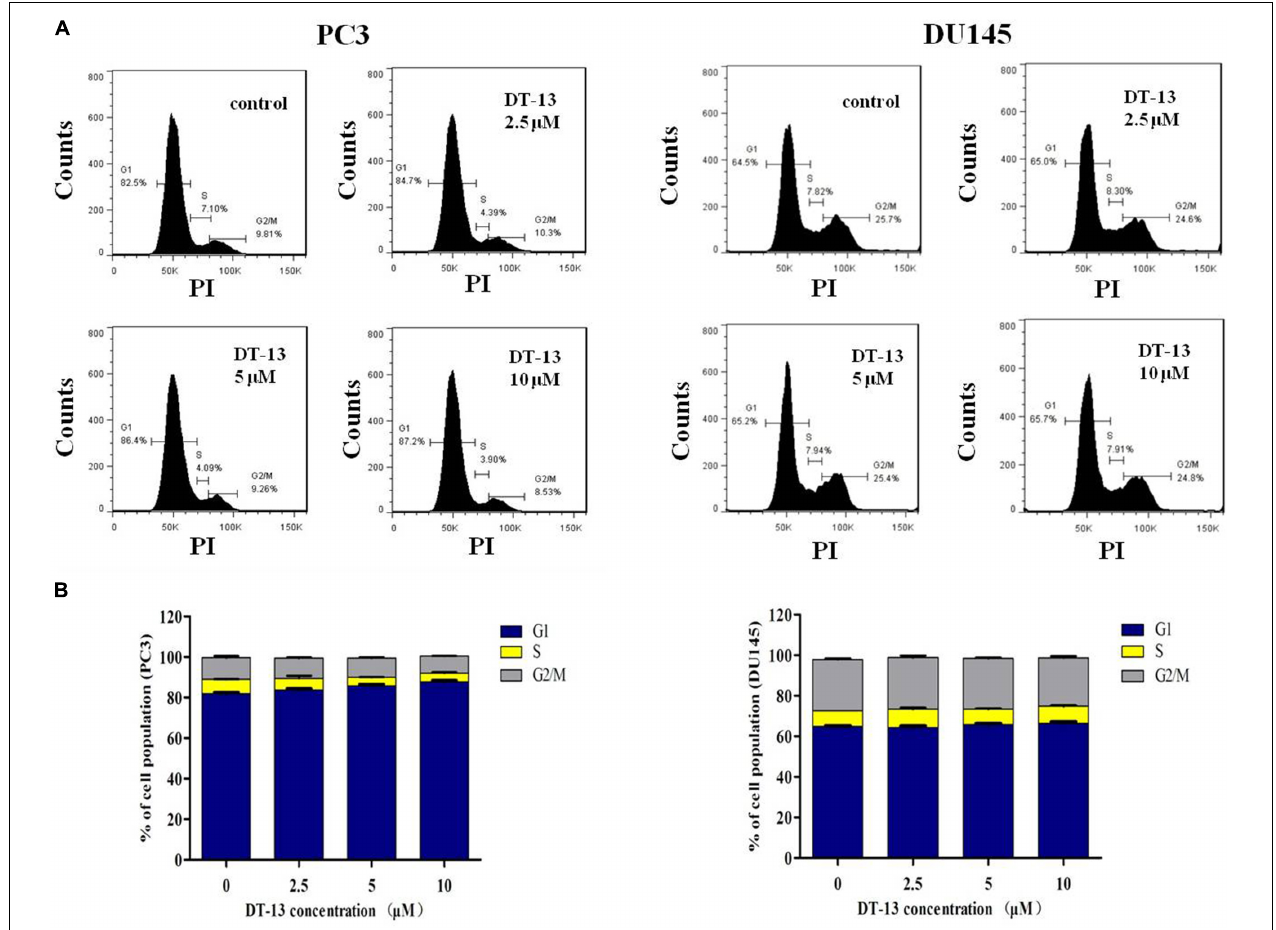
FIGURE 4 | DT-13 did not affect cell cycle distribution obviously. (A) PC3 and DU145 cells were incubated with various concentrations of DT-13 (2.5, 5, and 10 µ M) for 48 h, and the cell cycle distribution was determined by flow cytometry followed by PI staining. (B) Bar graphs show the percentages of PC3 and DU145 cells in G1, S, and G2/M phases. Data are presented as mean ± SD, representative of three independent